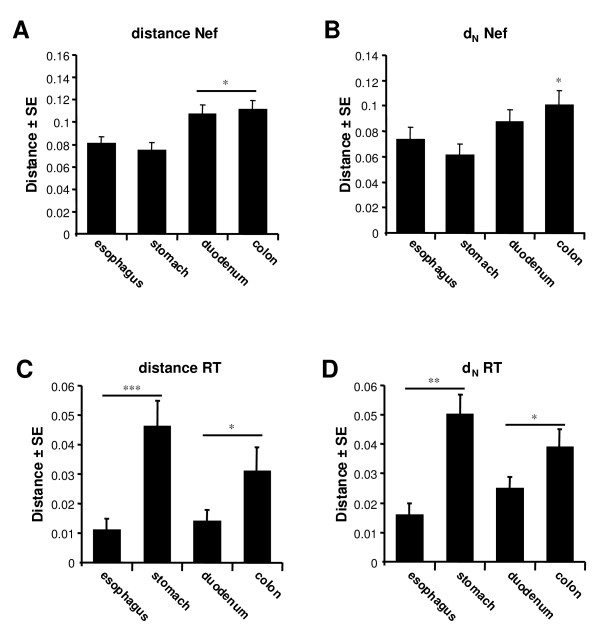
Viral molecular diversity of the Nef encoding region in gut tissues of HIV-1 patients. Viral Nef sequences were more diverse (higher mean total distance (d)) for the duodenum and colon compared to the stomach and esophagus (A). Moreover, viral evolution tended towards a more diverse Nef protein in the colorectum as reflected by a significantly higher mean total non-synonomous distance (dN, i.e. amino acid changing mutations) (B). A similar analysis of the RT coding region of HIV-1, also revealed significant differences in viral molecular diversity in the different tissues for both mean total distance (d) (C) and non-synonomous distance (dN) (D). These observations indicated that different selection pressures were acting in different parts of the gut depending on the viral region. (* = p < 0.05, ** = p < 0.01 ***, = p < 0.001, Dunn's multiple comparison test).